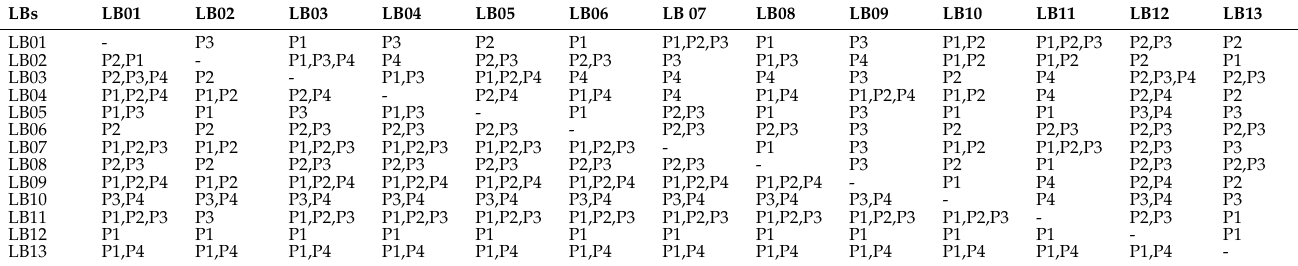
Table 10. Dominance interaction matrix (DIM).